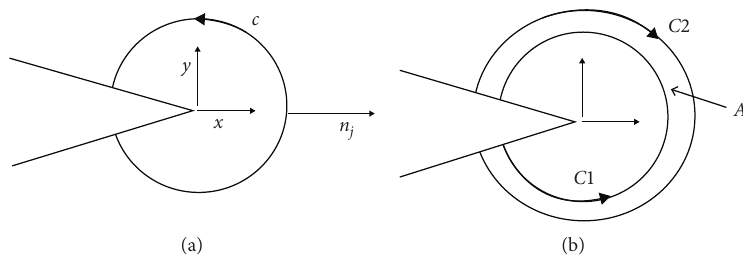
Figure 1: (a) Arbitrary contour consisting of the tip of the crack and (b) area considered to determine J